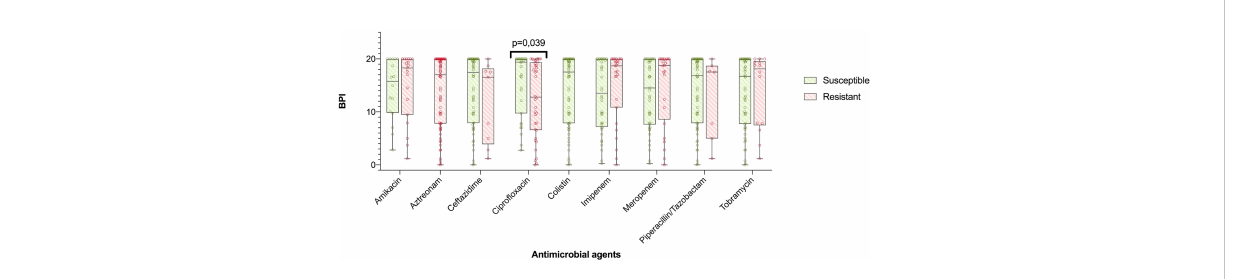
FIGURE 3 BPI in accordance to antibiotic resistance. The boxplot represents median and interquartile ratio, whiskers represent minimum and maximum values. Differences in the BPI in accordance to antibiotic resistance pattern where only statistically signi fi cant comparing cipro fl oxacin resistant vs. susceptible PA (12,94 [6,58-19,37] vs. 19,38 [9,73-20,00], p=0.039,